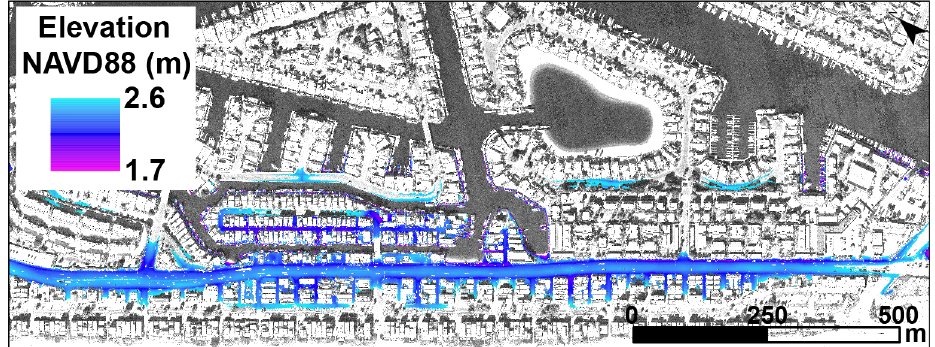
Figure 10. Elevations within the Pacific Coast Highway boundary ranging from low (purple) to high (blue). Background imagery from NOAA